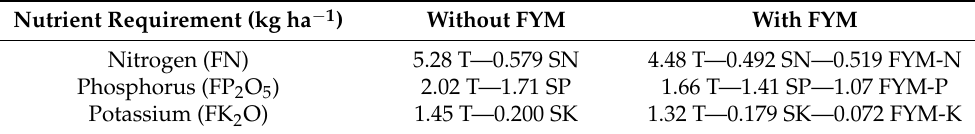
Table 6. Fertilizer-prescription equations as per the STCR for the target-yield of DSR. Nutrient Requirement (kg ha − 1